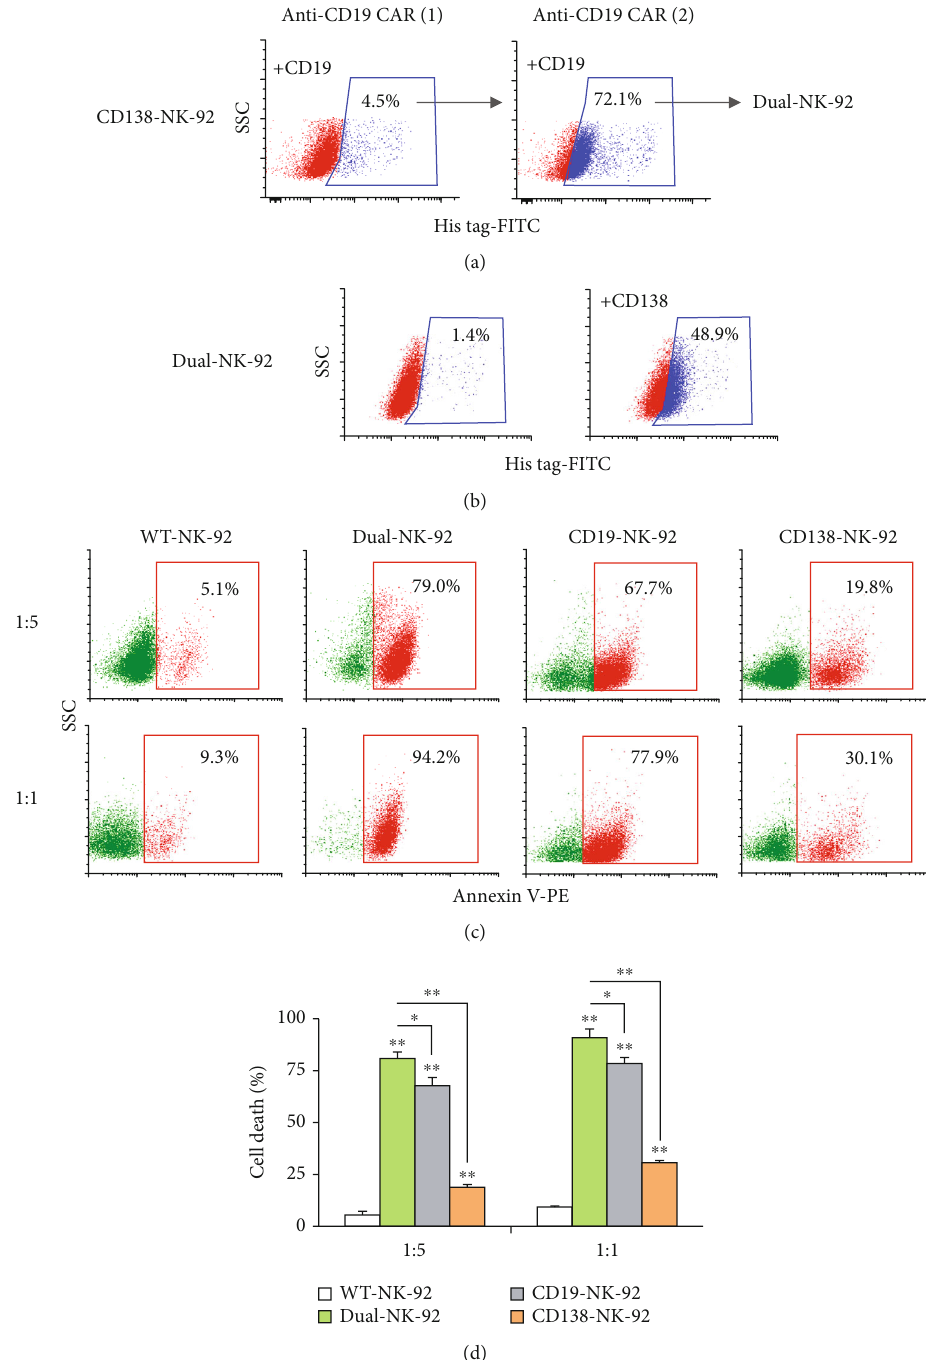
Figure 6: Generation of dual CD19/CD138-NK-92 cells and its cytotoxicity against ALL cells expressing both CD19 and CD138 antigens. (a) Stable CD138-NK-92 cells were subjected to multiple rounds of lentiviral transduction of anti-CD19-CAR and sequential FACS enrichment based on CD19 antigen-binding activity to obtain dual-NK-92 cells. (b) Anti-CD138-CAR expression in dual-NK-92 cells, as evaluated by fl ow cytometry based on its antigen-binding activity to His tag-rhCD138. (c) Human ALL-derived REH cells were labeled with PKH67 dye; incubated with WT-NK-92, dual-NK-92, CD19-NK-92, or CD138-NK-92 cells at the E : T ratio of 1 :5 or 1:1 for 4 h; and stained with Annexin V-PE. Representative fl ow cytometric dot plots of Annexin V-positive cells ( red box ) in PKH67-labeled cells were shown. (d) Percentage of REH cell death was plotted. Data are mean ± s : d : ( n = 3 ). ∗ p < 0 : 05 and ∗∗ p < 0 : 01 versus WT-NK-92 cells or dual-NK-92 cells as indicated; two-sided Student ’ s t